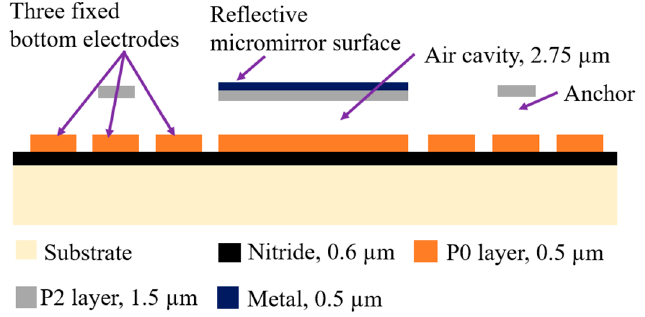
Figure 7. Cross-sectional view of the resulting micromirror.